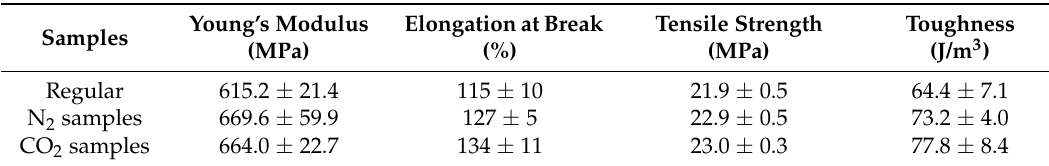
Figure 3. ( a – c ) Mechanical properties of UHMWPE samples and ( d ) an image of the breaking point. Table 5. Tensile properties of injection-molded samples.